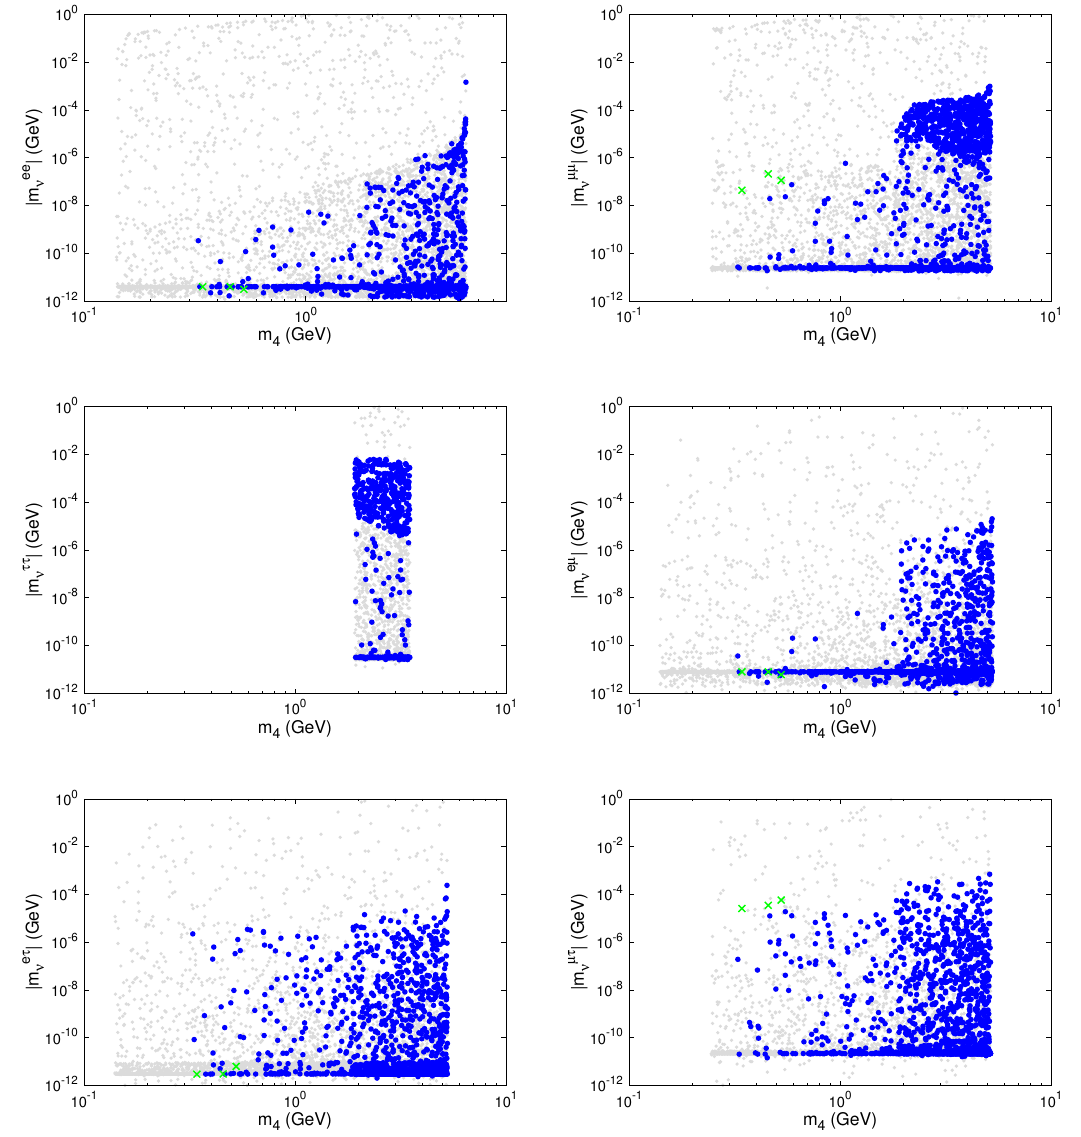
Figure 17 . Predictions for the e(cid:11)ective mass m (cid:11)(cid:12) as a function of the heavy (mostly sterile) (cid:23) fermion mass, m 4 , derived from the corresponding B ! ‘ (cid:11) ‘ (cid:12) (cid:25) LNV decay modes. Grey points are excluded due to the violation of at least one experimental or observational constraint (or to & 10 m), while the green crosses denote points which are excluded due to excessive having L (cid:13)ight (cid:23) 4 contributions to LNV decays.